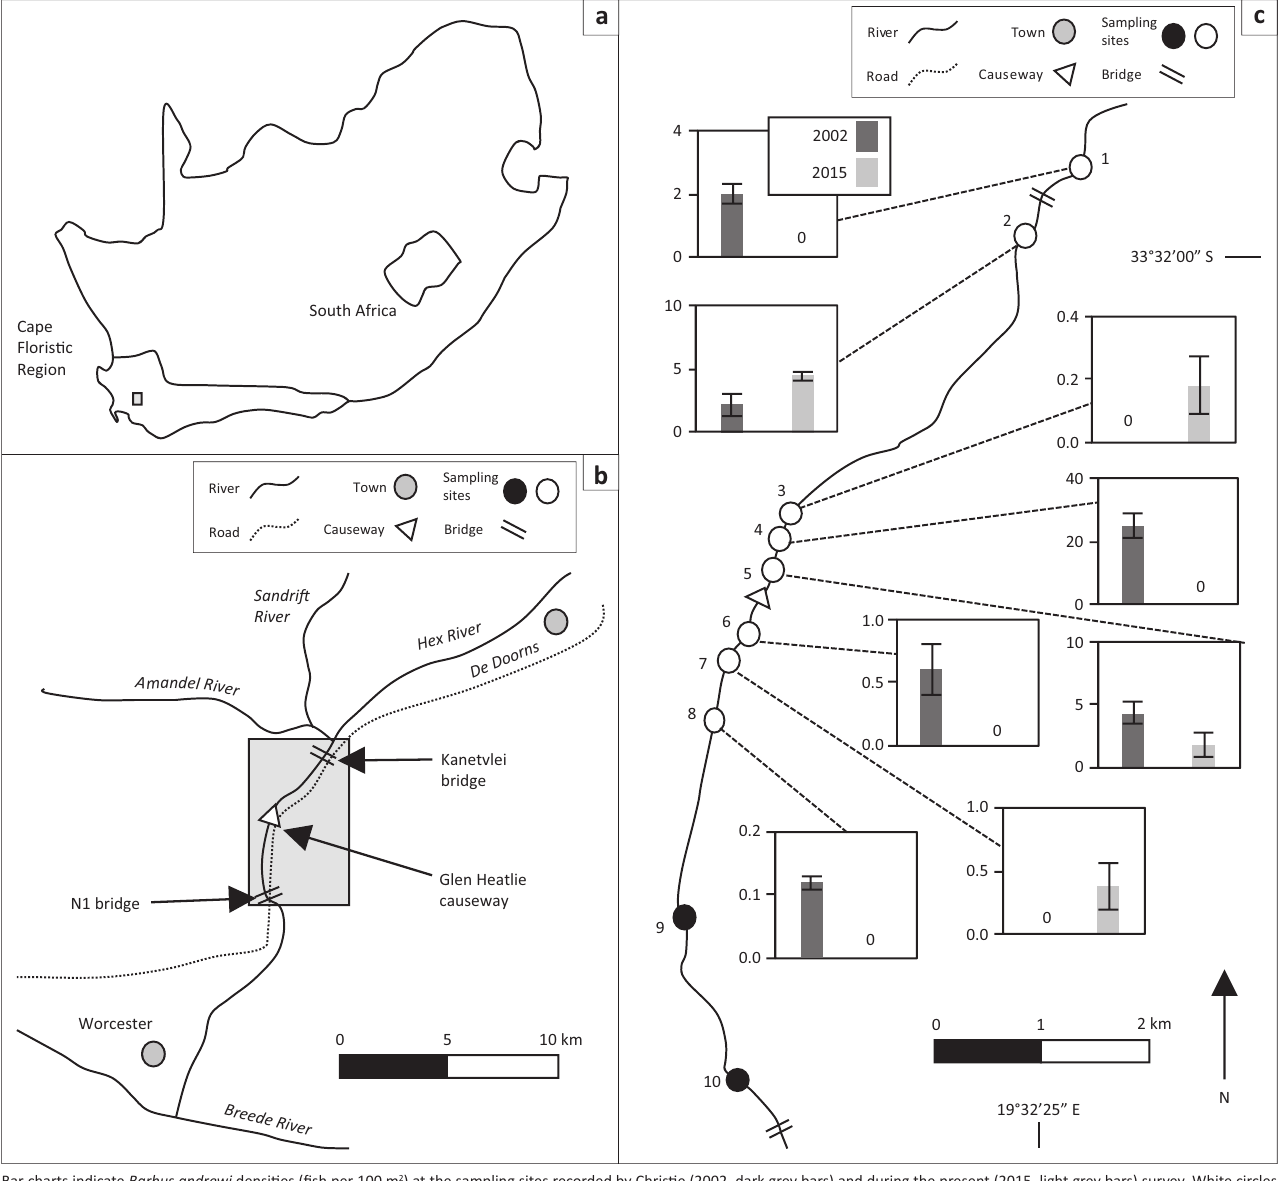
FIGURE 2: Location of (a) the Hex River catchment in the Cape Floristic Region, South Africa, (b) the location of the study area on the upper Hex River and key features referred to in the text and (c) the location of sampling sites within the study